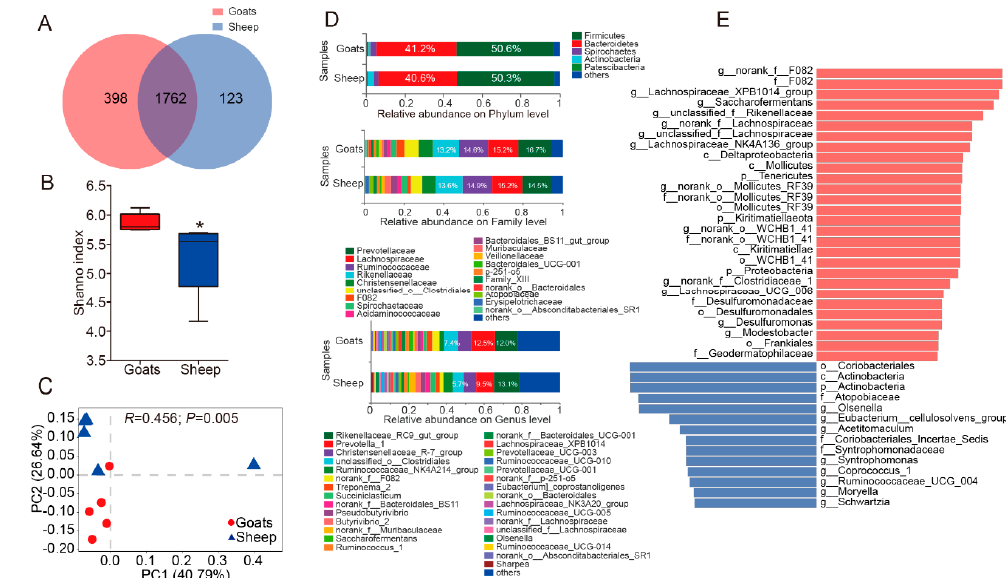
Figure 1. Diversity and composition of ruminal bacteria in goats and sheep. ( A ). Mutual and particular operational taxonomic unit (OTU) number of bacteria in goats and sheep. ( B ). Comparison of the diversity estimation of the bacteria based on One-way ANOVA, in which the y -axis represented Shannon index. The Shannon index was related to the richness and evenness of the microbial community. ( C ). Principal coordinate analysis (PCoA) profile of bacteria diversity in all samples using an unweighted UniFrac metric. The percentage of variation explained by PC1 and PC2 were indicated in the axis X and Y. Statistic (R) and p -value (P) were annotated by ANOSIM analysis between goats and sheep. ( D ). The illustration exhibited the relative distribution of the most dominant bacteria (1% of the total sequences) in goats and sheep at the phylum, family, and genus level. ( E ). Taxa with significantly different abundances at phylum (p), class (c), order (o), family (f), genus (g) levels are shown. The red color represented that the abundance of taxa was higher in goats and a blue color represented that the abundance of taxa was higher in goats. The higher the Linear Discriminant Analysis (LDA) score, the greater the effect of the taxa abundance on the difference between goats and sheep.